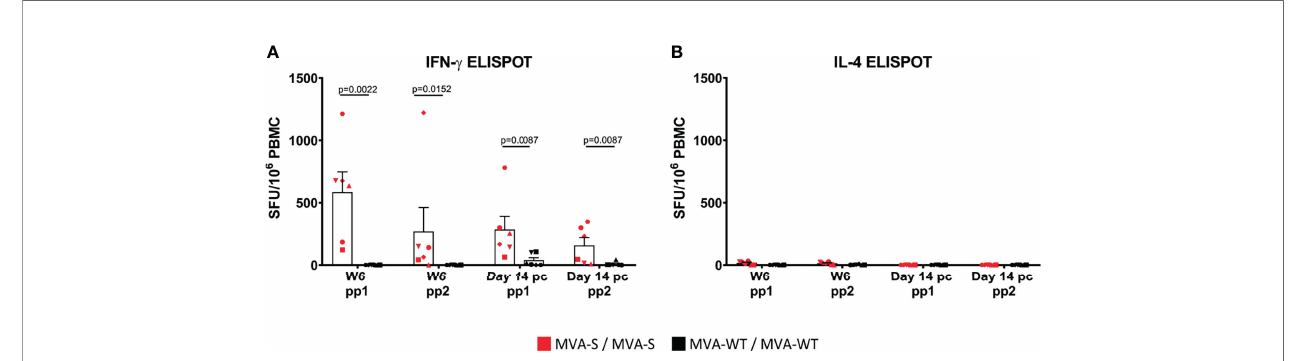
FIGURE 4 | SARS-CoV-2-speci fi c cell immune responses are induced by MVA-S. S-speci fi c IFN- g (A) and IL-4 (B) cell responses (directed against pp1 and pp2 peptide pools) 2 weeks post second immunization (Week 6) and 2 weeks post-challenge (day 14 pc) of MVA-S (red) and MVA-WT (black) immunized individual macaques, as measured by ELISpot assay. Each animal is represented by a symbol. Mean and SEM are shown in columns for each group of animals. Signi fi cant differences between the groups are indicated in the graph by a horizontal line and p-value (Mann – Whitney test).